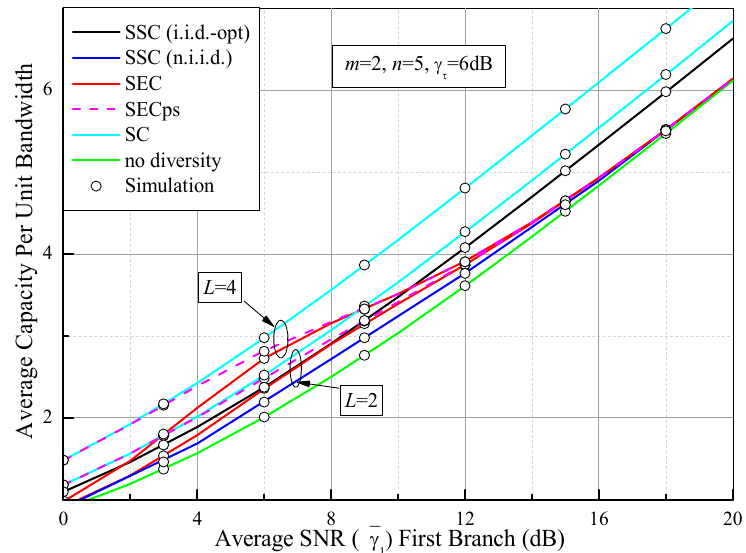
Figure 10. Comparison of the average capacity levels of different switched diversity systems as a function of the average SNR of the first branch ( γ 1 ) over Fisher–Snedecor F fading channels with m = 2, n = 5, and γ τ = 6 dB.